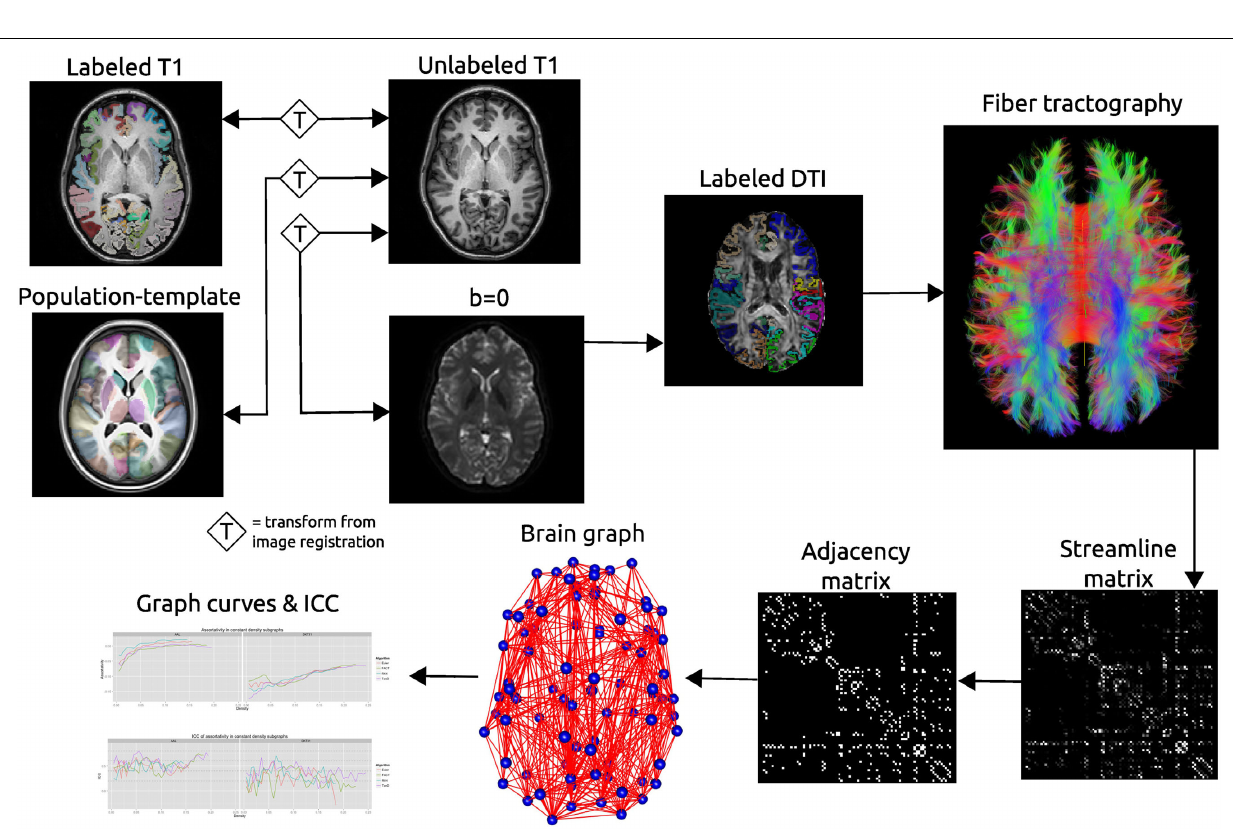
records the number of streamline connecting each pair of labeled regions. This matrix is thresholded as constant density to create an adjacency matrix which defines connections in a brain graph. Graph curves are generate by calculating network summary measures over a range of density values and ICC plots are used to examine the reproducibility of the